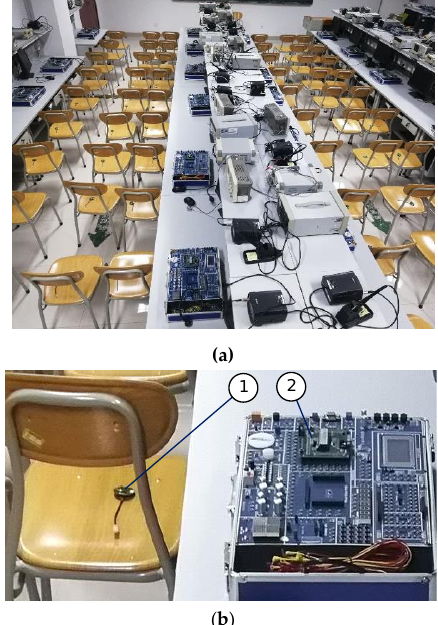
Figure 18. Node test site: ( a ) test site, ( b ) test details: (1) a sensor node, (2) the simulated concentrator unit.